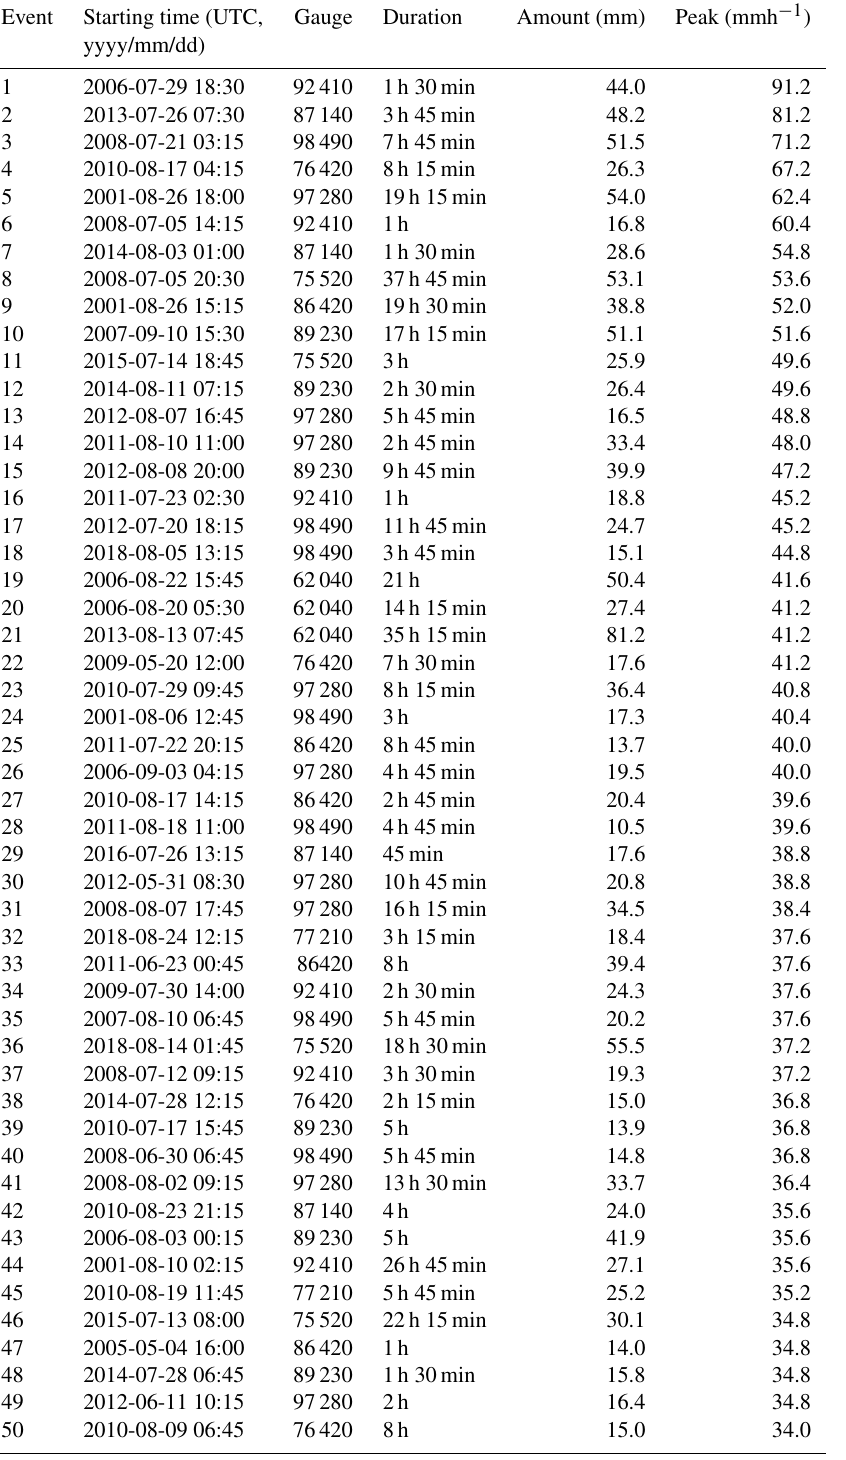
Table A4. Top 50 events for